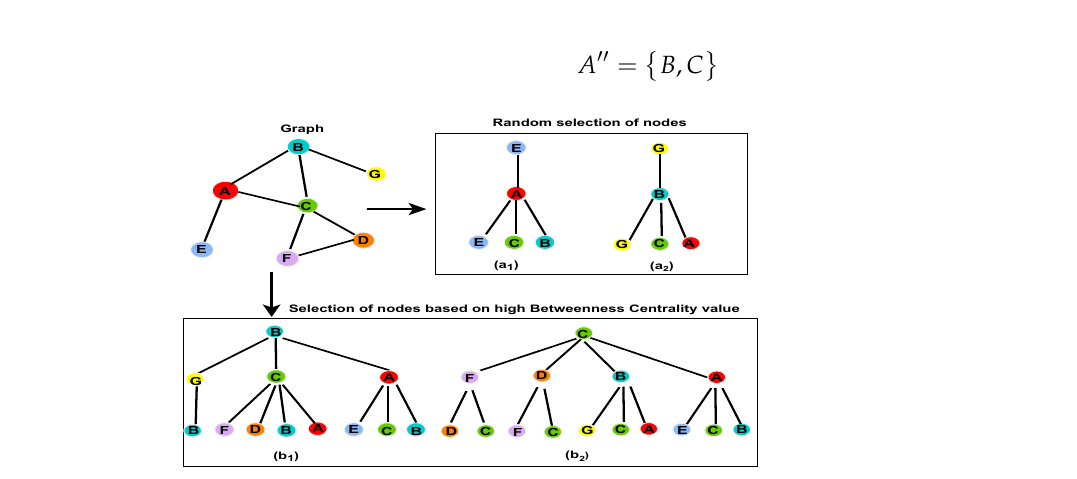
Figure 4. Node selection: a1, a2 (traditional random selection) vs b1, b2 (proposed